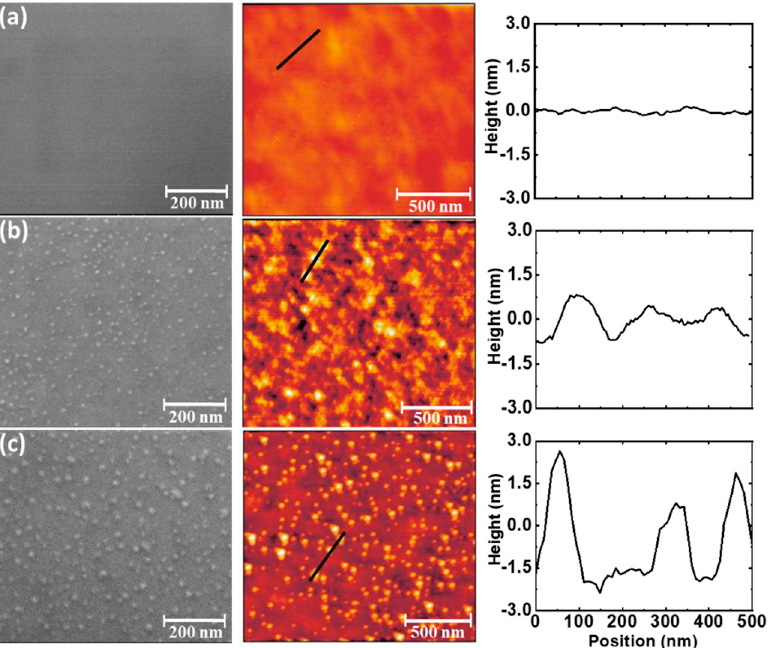
Figure 2. SEM micrographs ( left -hand image) and AFM images ( right -hand image) with the typical line profile of the same LNMO thin film (thickness, t = 48 nm) after different annealing processes: ( a ) as-grown film (no-annealing process), ( b ) annealing at 800 °C and ( c ) annealing at 900 °C.